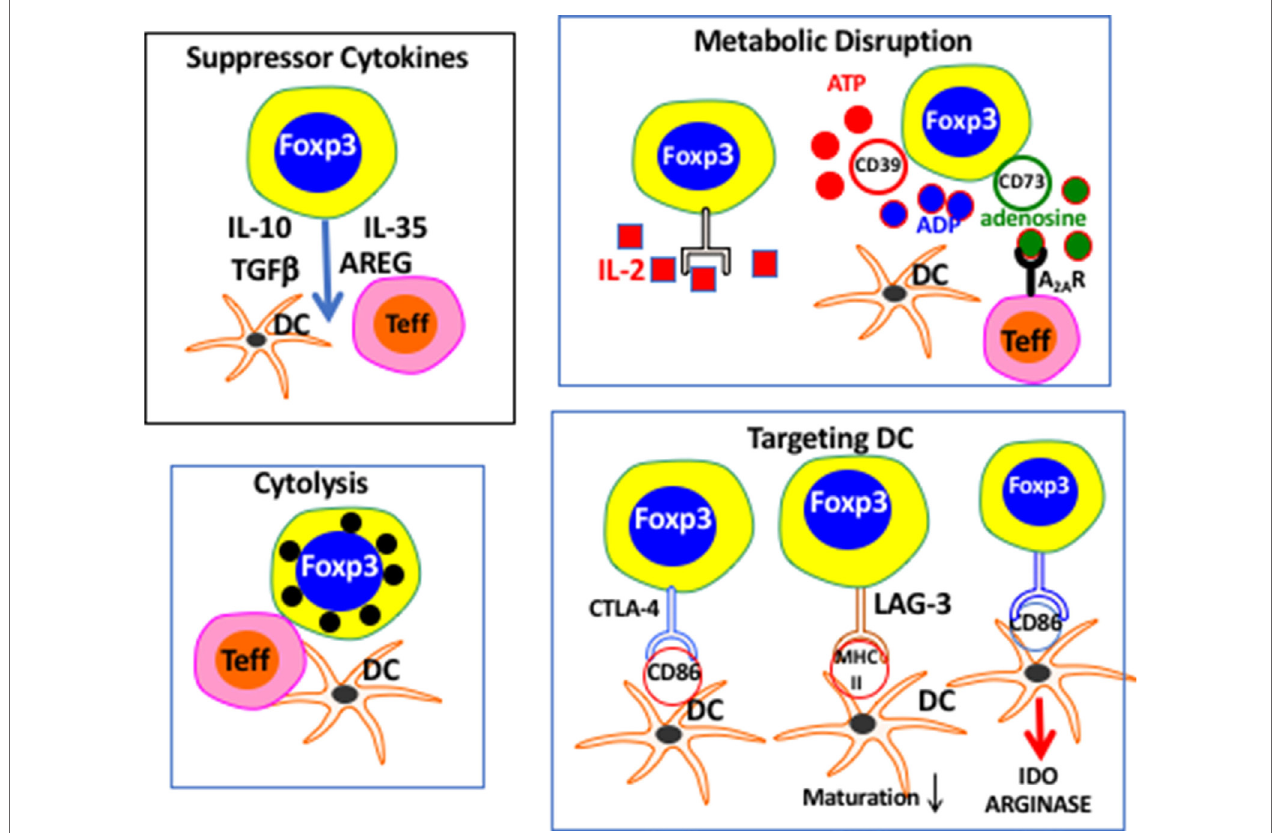
FigUre 2 | Proposed pathways of T regulatory (Treg)-mediated suppression. The pathways are roughly divided into different mechanistic categories. It remains unclear which or how many mechanisms are used by Treg under physiologic conditions in vivo